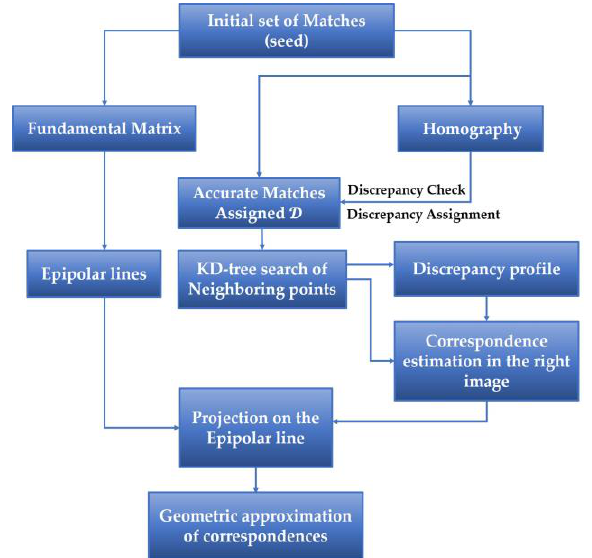
Figure 1. Geometric approximation (prediction) of the corresponding feature in the right image.